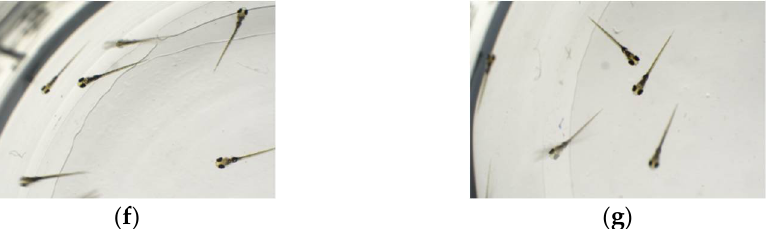
Figure 3. The phenotypic appearance of zebrafish fed with different concentration of FEAK. ( a ) Nor- mal control group. ( b ) Model control group. ( c ) 31.2 μg/mL of FEAK group. ( d ) 62.5 μg/mL of FEAK group. ( e ) 125 μg/mL of FEAK group. ( f ) 250 μg/mL of FEAK group. ( g ) 500 μg/mL of FEAK group.